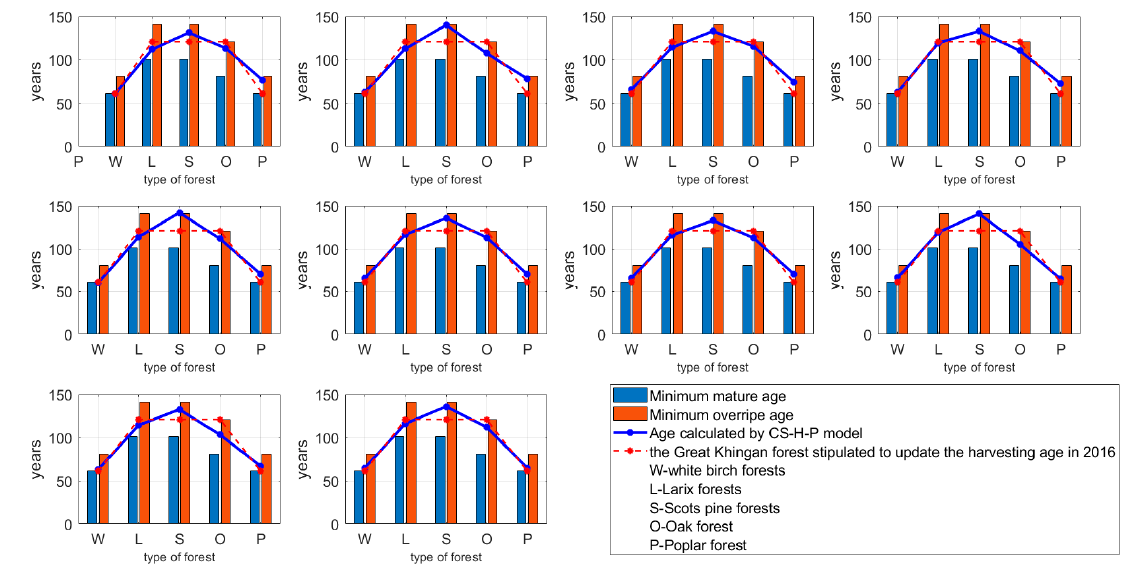
Figure 1. Analysis chart: The regeneration cutting age of natural forests.